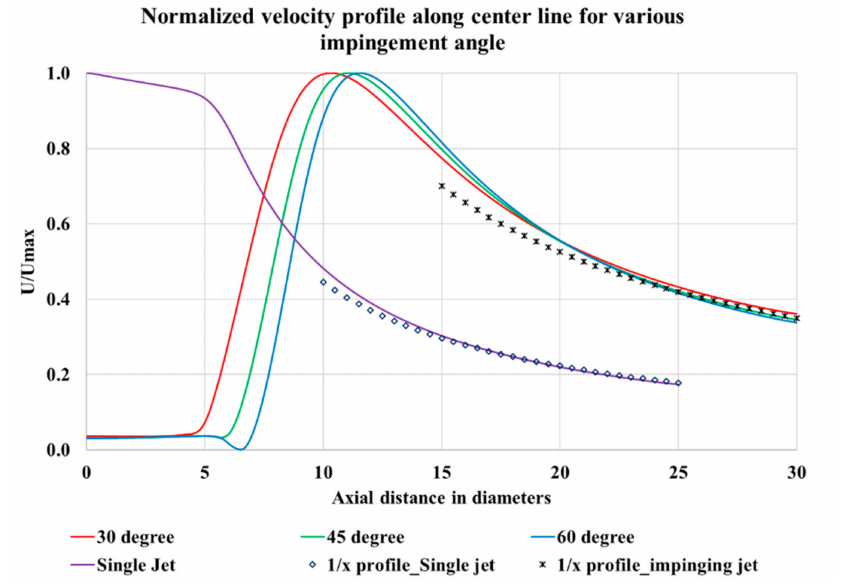
Figure 11. Normalized velocity profile along the center line compared with 1/ x